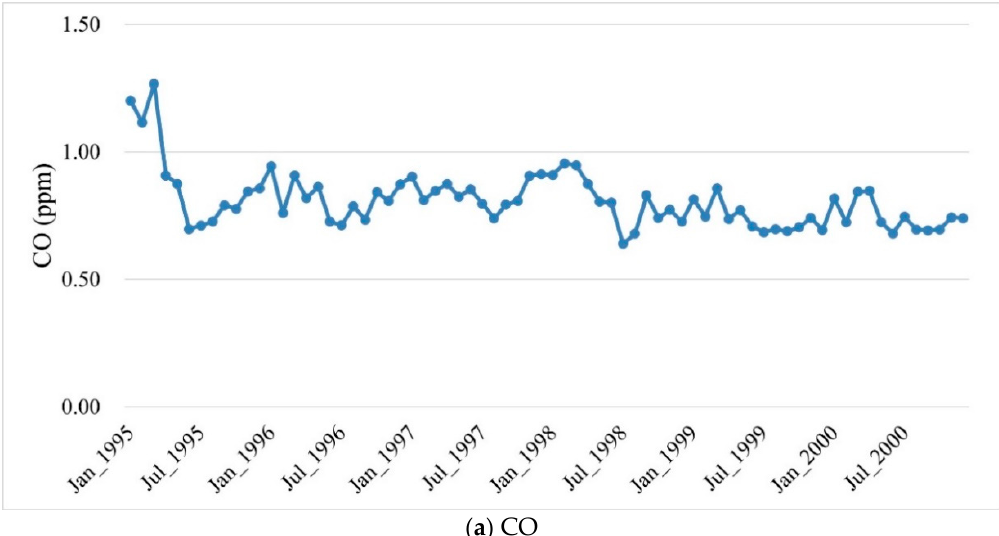
Figure 2. Cumulative incidence rates (per 10,000 children) of autism spectrum disorder and mean levels of air pollutants in Taiwanese townships during the study period.